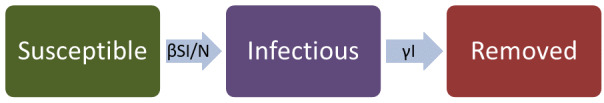
Flow diagram of transitions in susceptible-infected-removed (SIR) Model.